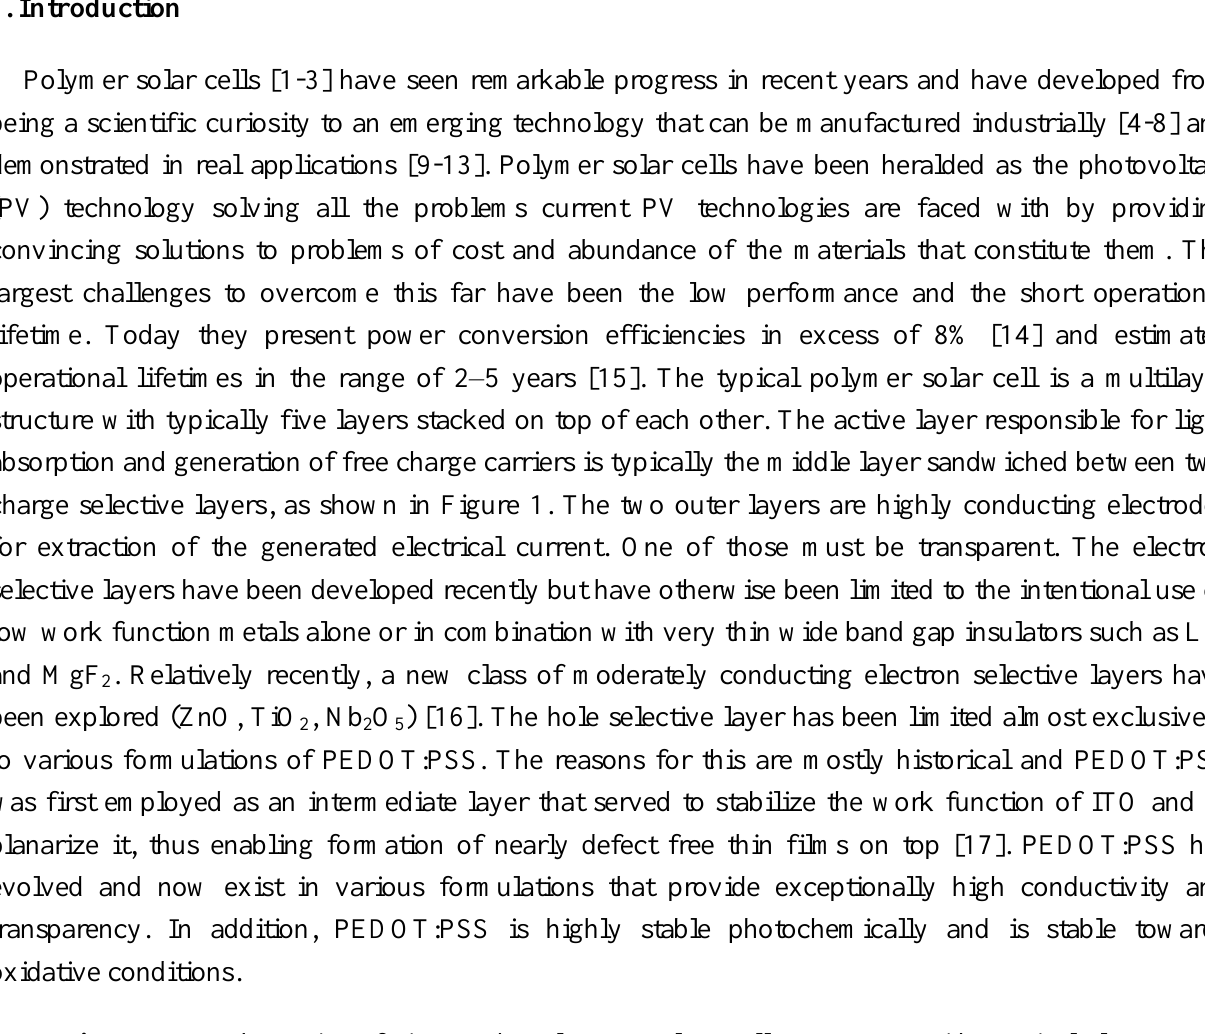
Figure 1. Schematic of inverted polymer solar cell structure with typical layer thicknesses